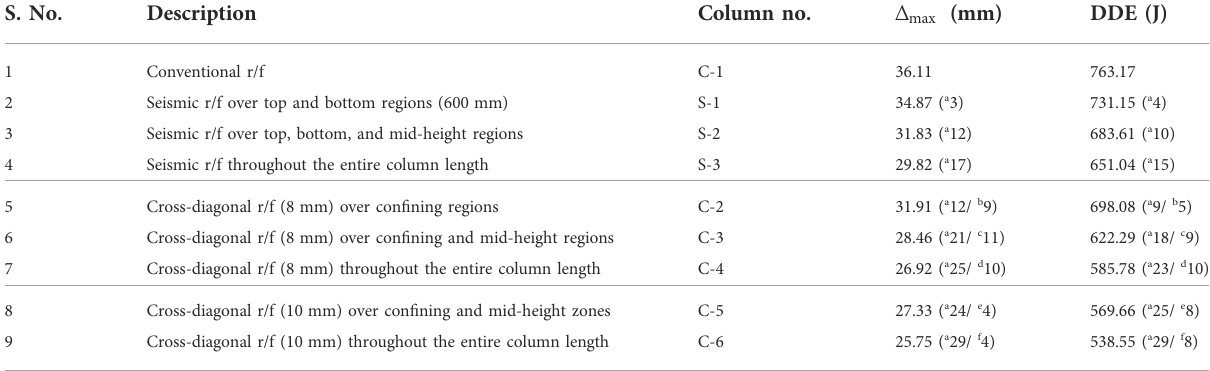
TABLE 3 Summary of maximum transverse mid-height displacement ( Δ max ) and damage dissipation energy (DDE). S.